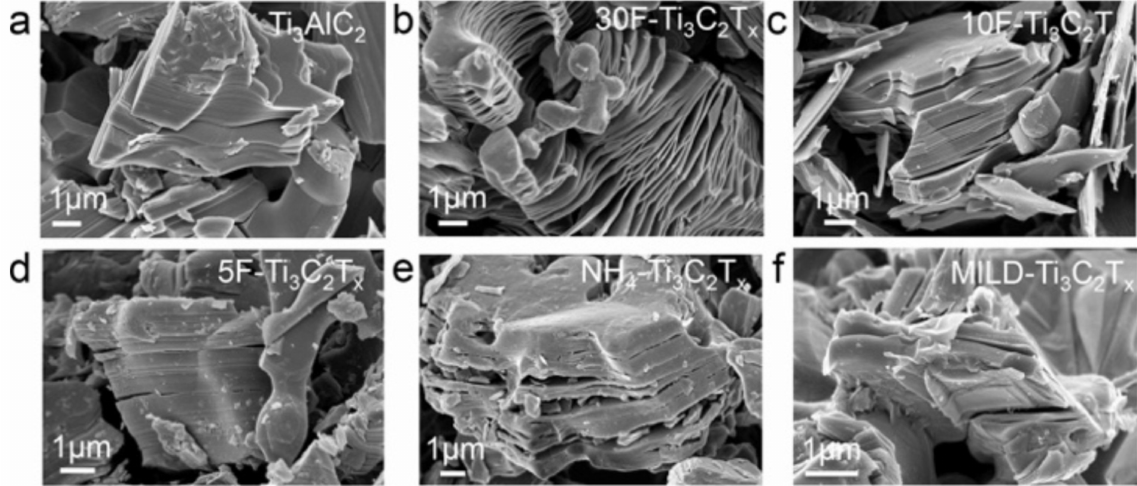
Figure 8. SEM images of MAX phases and MXenes synthesized with different etching routes, ( a ) Ti 3 AlC 2 MAX phasewith compact structure. Multilayered Ti 3 C 2 T x MXene obtained with HF concentration of ( b ) 30 wt%, ( c ) 10 wt%, and ( d ) 5 wt%. Only for 30 wt% the accordion-like mor- phology is observed for HF-etched powder. ( e ) Multilayered NH4-Ti 3 C 2 T x .powder synthesized